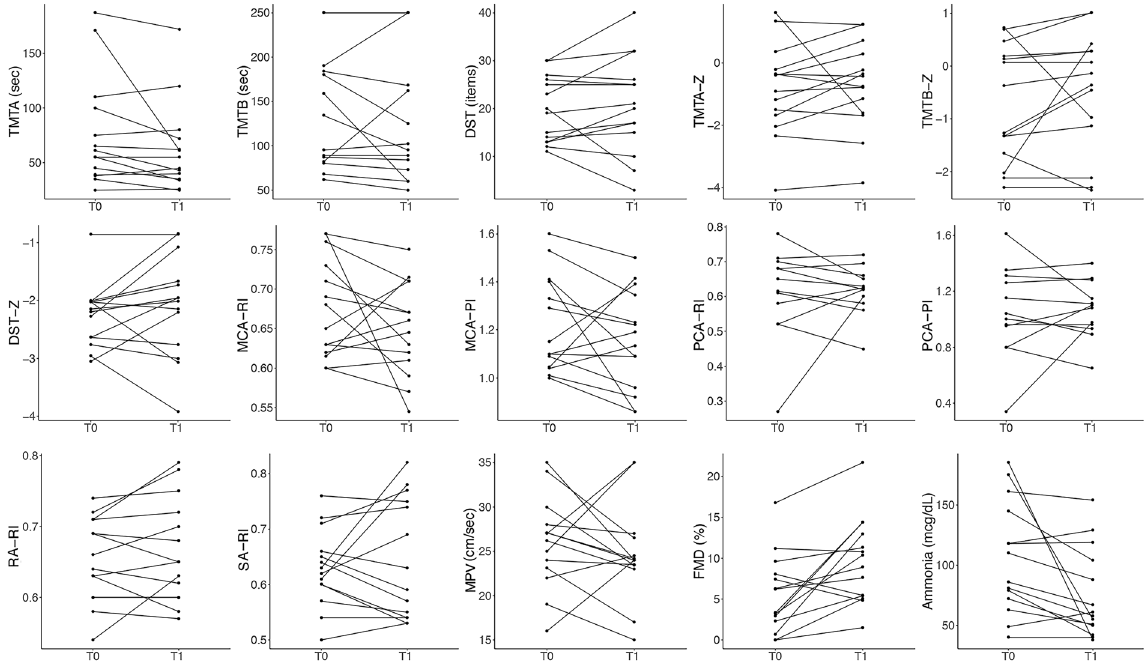
Figure 3. Change in cerebral and splanchnic vascular resistance parameters, flow mediated dilation (FMD), neuropsychological tests results (expressed as rough or standardized values) and ammonia serum level after rifaximin treatment in cirrhotic patients with minimal hepatic encephalopathy (MHE). RI = resistive index; PI = pulsatility index; MCA = middle cerebral artery; PCA = posterior cerebral artery; RA = renal artery; SA = splenic artery; MPV = mean portal vein velocity; FMD = flow mediated dilation; TMT = trail making test; DST = digit symbol test.